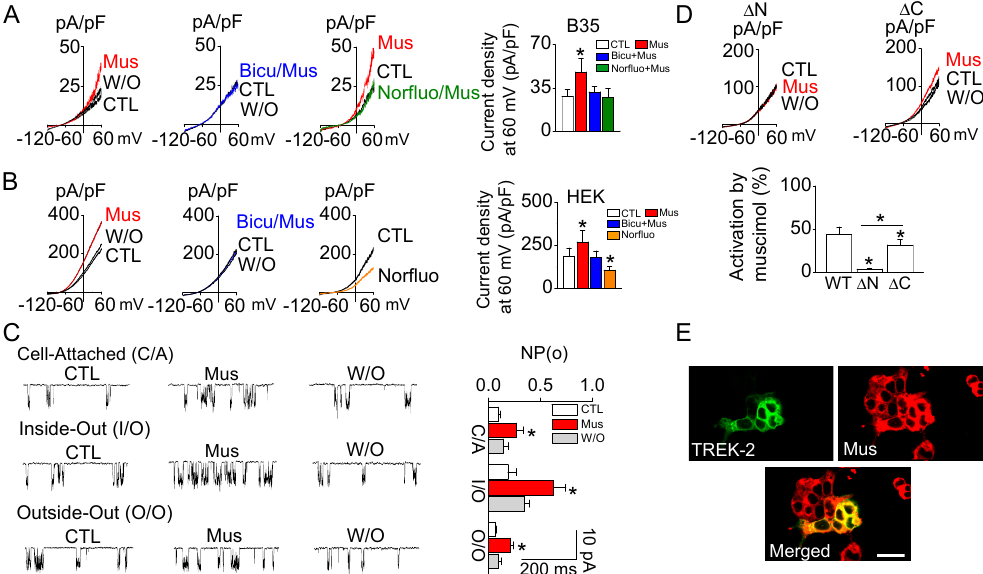
Figure 4. TREK-2 activation by muscimol. ( A ) Background K + currents recorded in B35 cells. The currents were recorded in the presence of 4-aminopyridine (4-AP, 1 mM), BaCl 2 (1 mM), and TEA (1 mM) to rule out the involvement of other K + channels. ( B ) Muscimol-induced activation of TREK-2 currents in HEK-293 cells. TREK-2 was transfected into HEK293 cells. ( C ) Effect of muscimol on TREK-2 activation under different patch configurations. The muscimol was applied to the bath solution at a rate of 6 mL/min. The number of events analyzed for comparison of NPo was 2000. Channel activity was analyzed within 1 min after the application of muscimol at -60 mV. ( D ) The action sites of muscimol on the TREK-2 wild-type and N-terminal and C-terminal deletion ( Δ N and Δ C) mutants. The whole-cell current was recorded in response to a voltage ramp ( − 120 to +60 mV; 1 s duration) from a holding potential of − 80 mV. The currents measured at +60 mV were analyzed. ( E ) Binding assay of TREK-2 and muscimol. TREK-2 in the pcDNA3-EGFP vector was transfected into HEK-293 cells, and the BODIPY ® TMR-X muscimol conjugate was stained. Scale bar, 30 μ m. Each bar ( A to D ) represents the mean ± SD of three independent experiments ( n = 12). * p < 0.05 compared to the control.